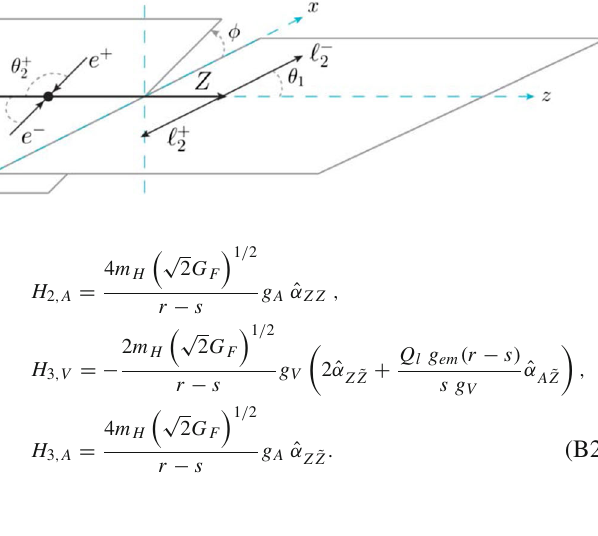
Fig. 7 Kinematics for the scattering e + e − → Z H → l + l −